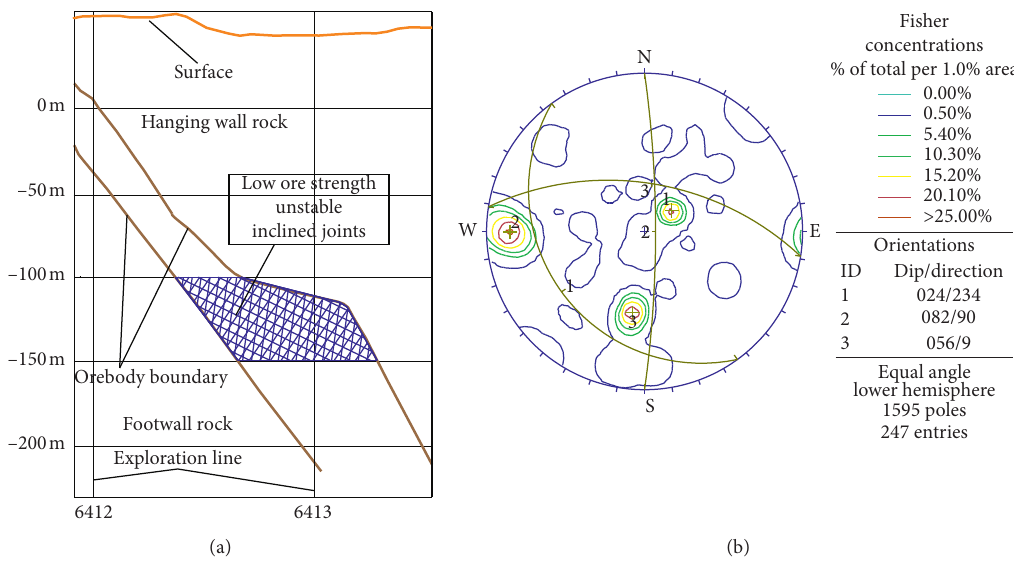
Figure 1: Orebody and inclined joints. (a) Orebody profile. (b) Contour plot of